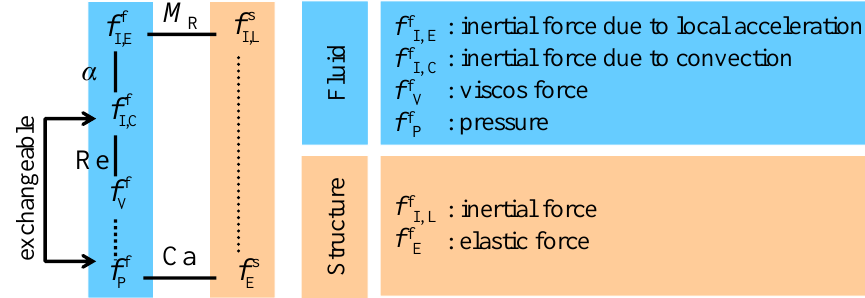
Figure 3. Schematic view of the present dynamic similarity framework.